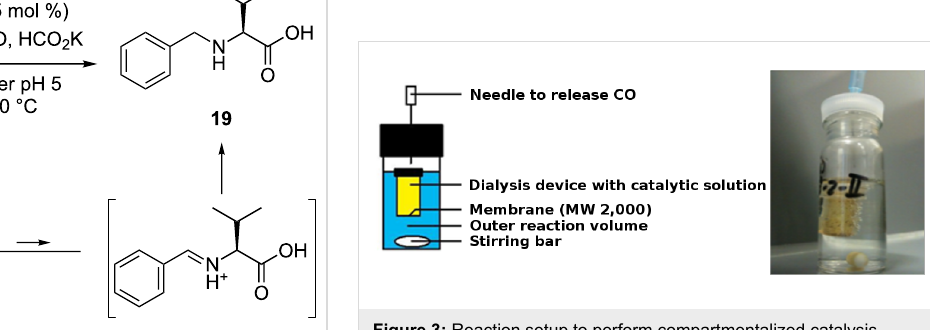
Figure 2: Formation of 19 catalyzed by the three iridium catalysts.